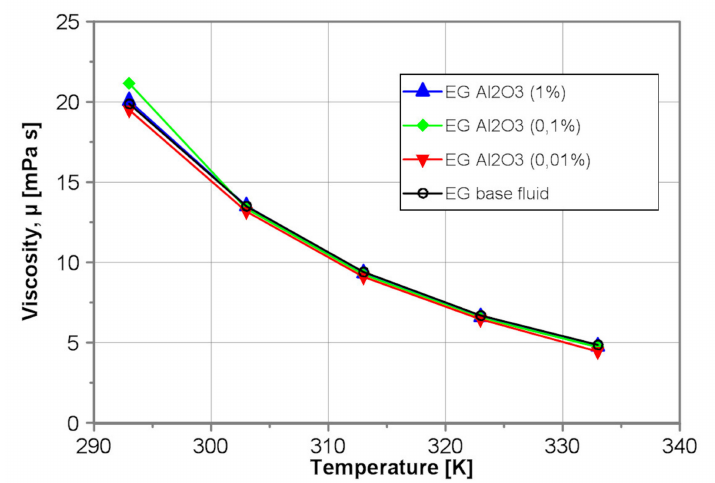
Figure 5. Dynamic viscosity of the tested EG-Al 2 O 3